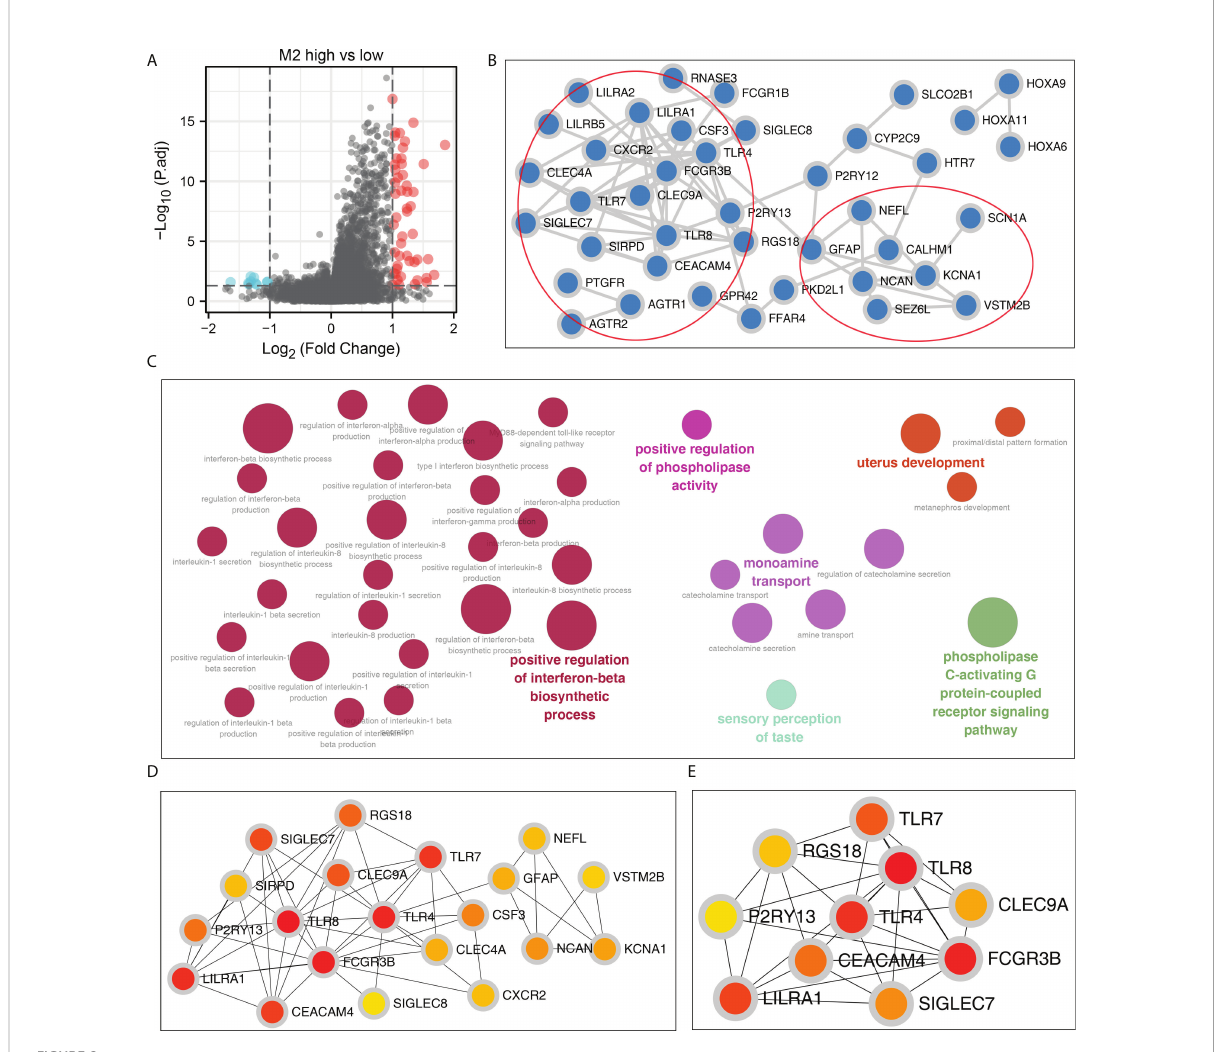
FIGURE 2 Construction of the PPI network. (A) DEGs were identi fi ed between high and low M2 macrophages patients using the limma package with the threshold of |logFC| > 1 and P.value < 0.05; (B) The PPI network of the DEGs; (C) ClueGO analysis of nodes; (D, E) Top 20 and 10 important nodes of the PPI network based on the cytohubba plug